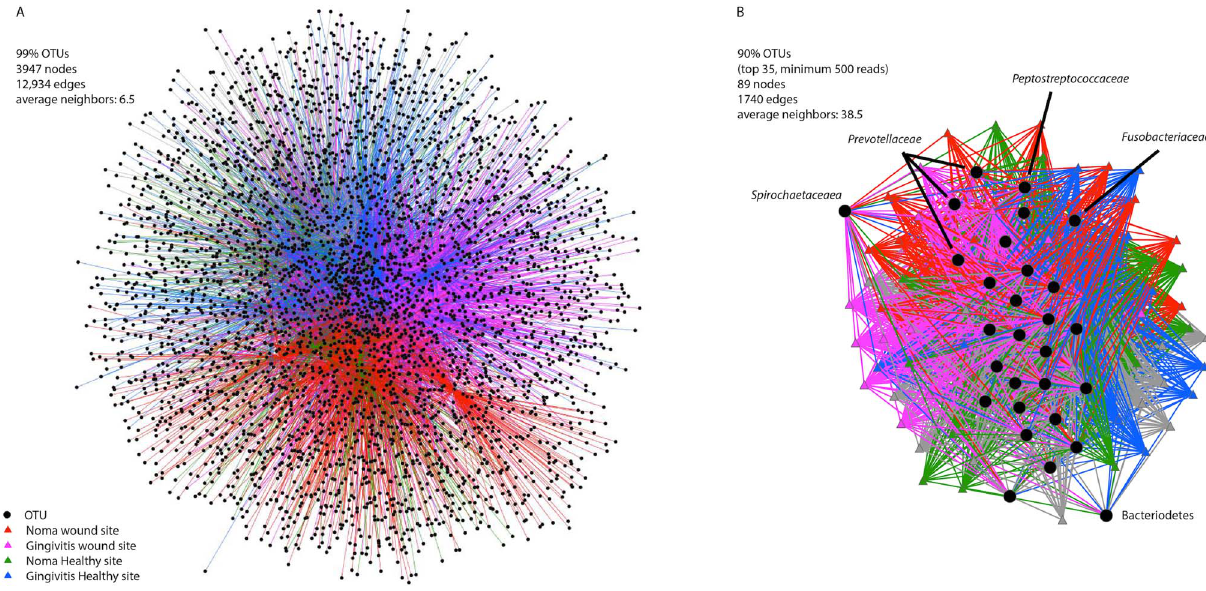
Figure 5. Network analysis of bacterial communities. The network in (A) was created using the 99% OTUs whereas (B) was created using the top 35 OTUs from the 90% cutoff dataset. The data in (B) are also shown as a barplot in Figure S1, and as a Venn diagram in Figure S2A.